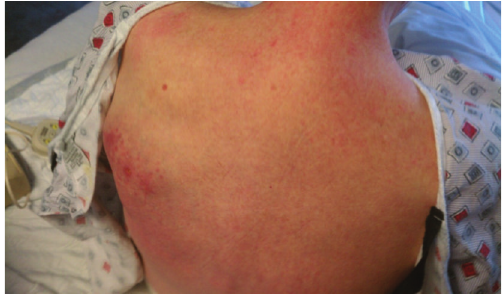
Figure 1: Focal area of involvement on posterior chest wall.